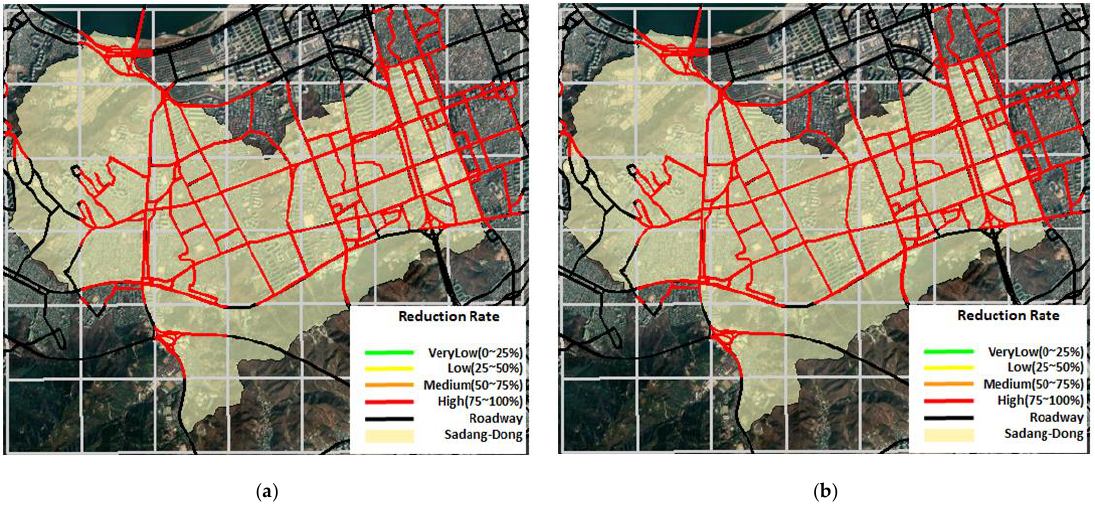
Figure 19. Vehicle speed variation over time.